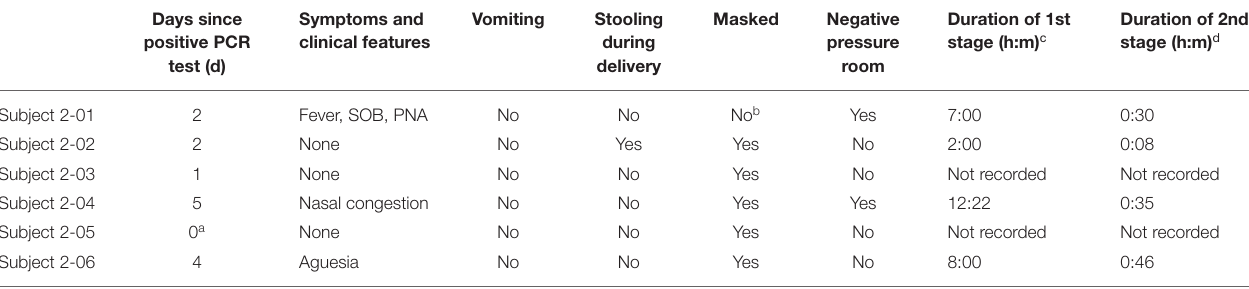
TABLE 1 | Patient clinical characteristics and labor environment.